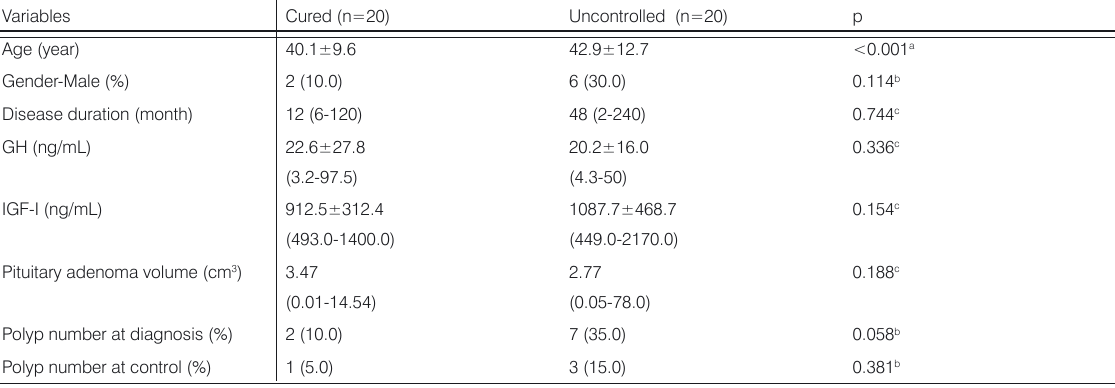
a Student’s t test. b Pearson Chi-square